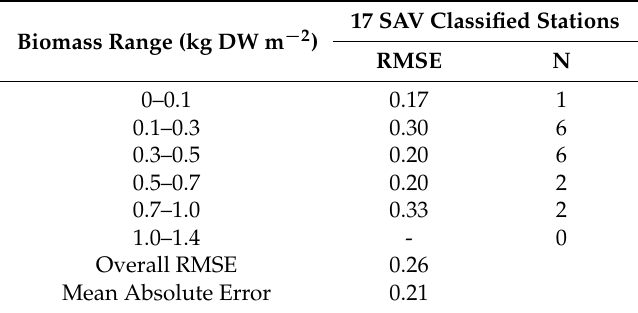
Table 7. Estimated RMSE of SAV biomass for the classified stations (September 2014).